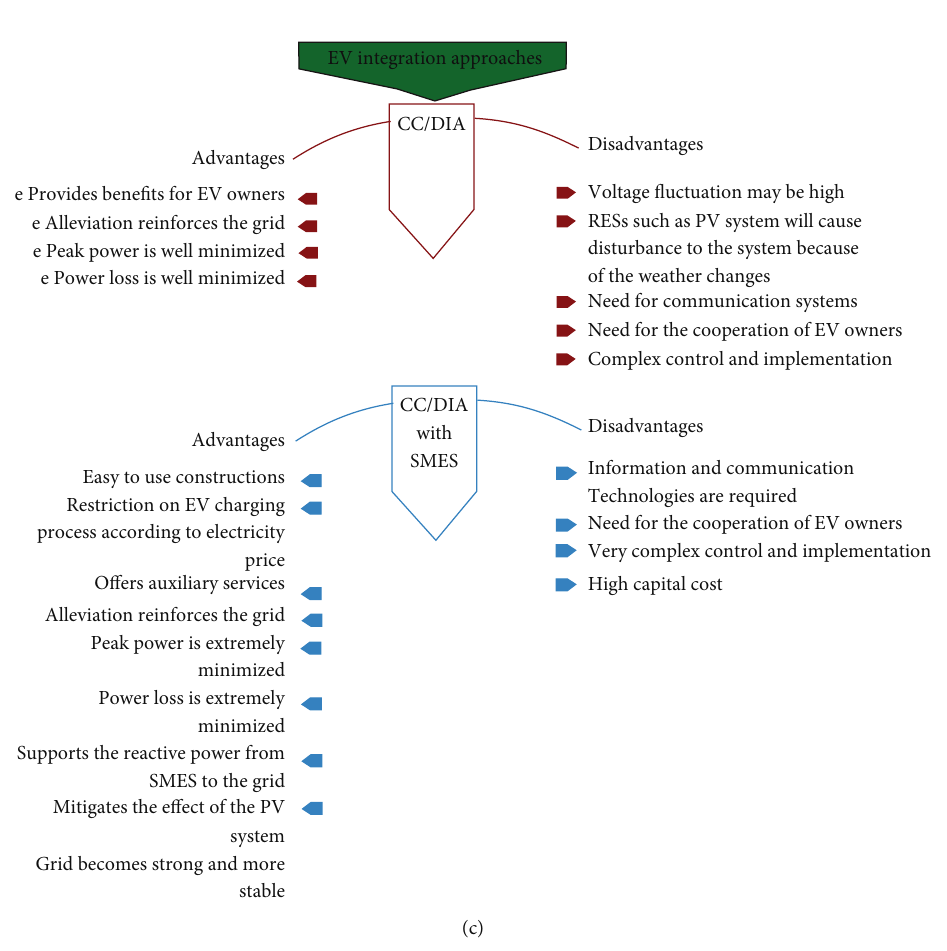
Figure 19: Advantages and disadvantages of the EV integration